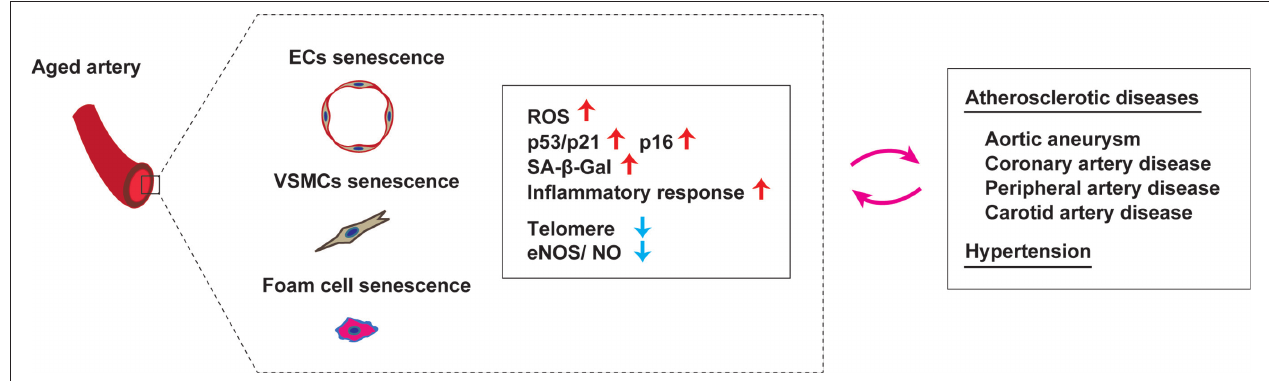
FiguRe 3 | Cellular senescence in aged arteries. Aged arteries are characterized by accumulation of senescent vascular endothelial cells (EC), senescent vascular smooth muscle cells (VSMCs), and senescent foam cells. Accumulation of these senescent cells are associated with an increase of ROS, p53/p21, p16, SA- β -Gal, inflammatory response, telomere attrition and reduced eNOS/NO level). Senescence of these cells promotes pathological changes in atherosclerotic diseases and also has a role in development of